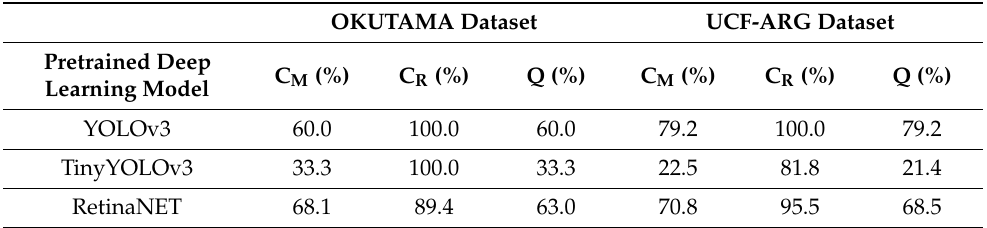
Table 2. Quantitative object detection results for the first 30 frames of the OKUTAMA and UCF- ARG datasets.